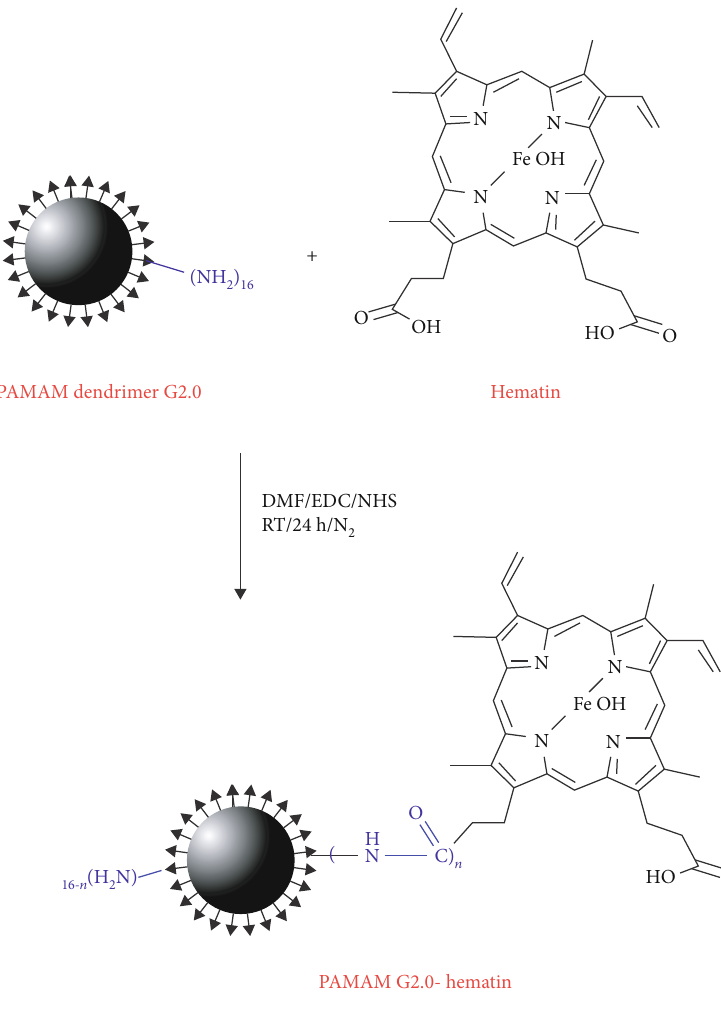
Figure 1: Schematic illustration of the of PAMAM dendrimer G2.0-hematin